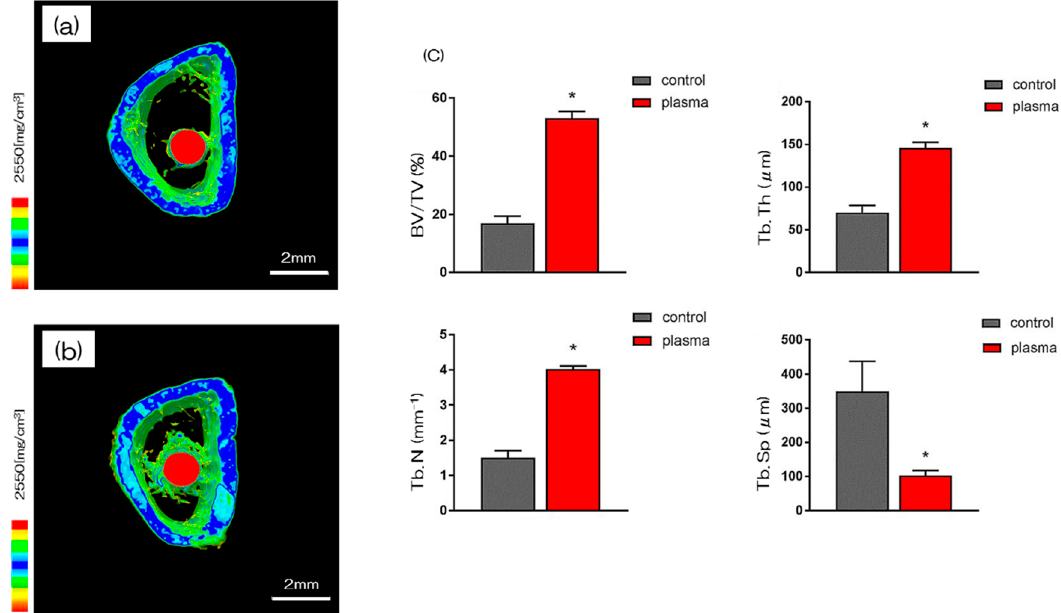
Figure 5. The reconstructed three-dimensional macro-CT images of rat femurs transverse slices showed that thin new bone layers are formed round the implants in the test and control group after 8 weeks. ( a ; control, b ; test) In both ( a , b ), new bone formation was observed around the implant model, but in ( b ), more new bone formation was observed. ( c ) The BV / TV, Tb.N, and Tb.Th were significantly higher in the test group samples than that of the control group (* p < 0.05). Conversely, Tb.Sp was significantly lower in the test group than that of the control group.